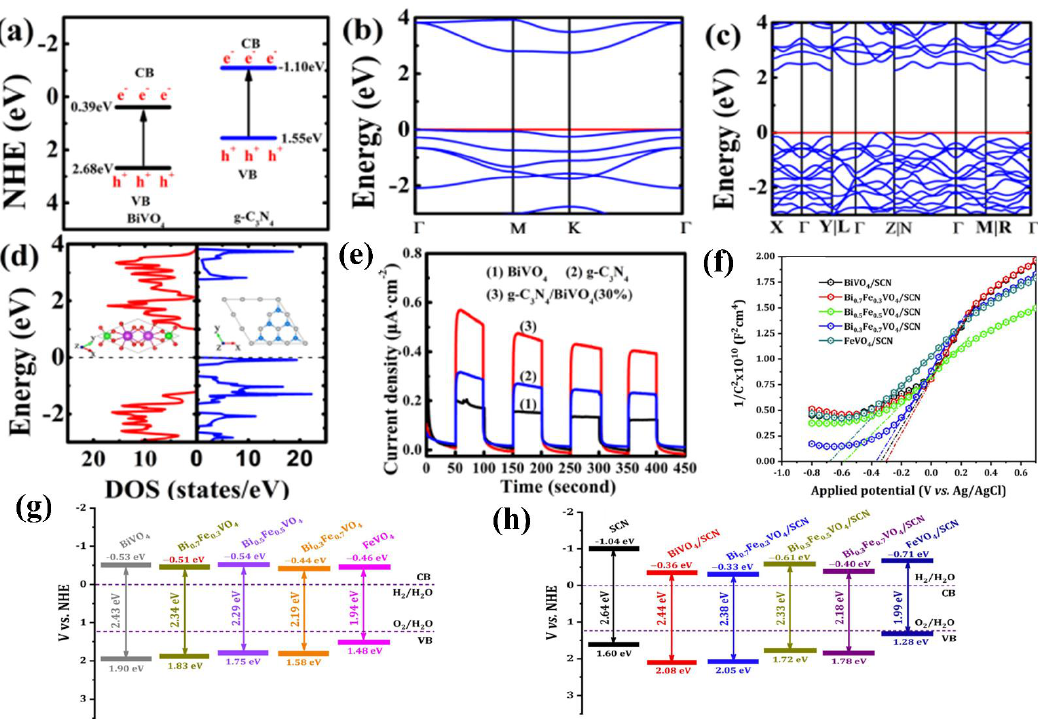
Figure 22. ( a ) Schematic diagram of the band alignment. ( b ) The band structure of calculated g−CN . ( c ) The band structure of calculated BiVO 4 . ( d ) Densities of sates g−CN and BiVO 4 . ( e ) Transient photocurrent response. Reprinted with permission from ref. [226] Copyright 2019 American Institute of Physics. ( f ) The electrochemical Mott-Schottky plots and ( g , h ) their corresponding energy level band edge diagram. Reprinted with permission from ref. [228] Copyright 2022 Elsevier.